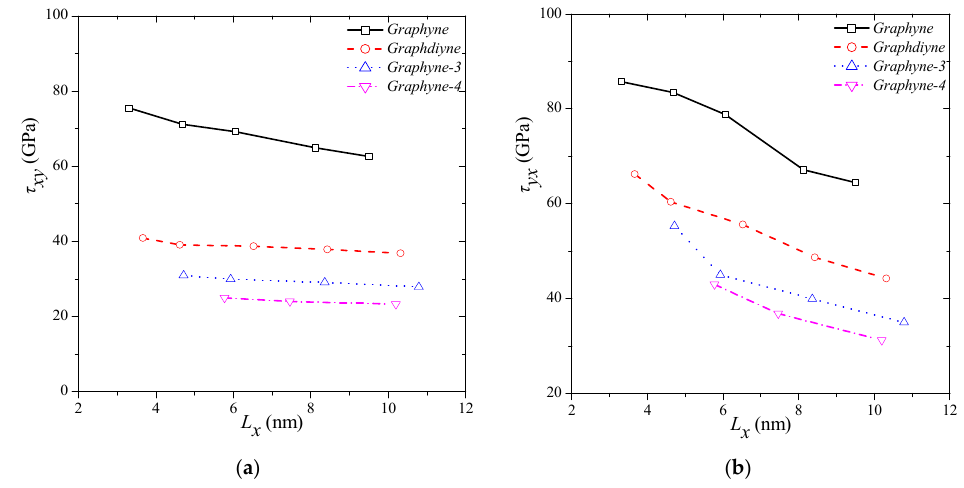
Figure 7. Shear strength variations in different graphyne structures in ( a ) x–y and ( b ) y–x direction.